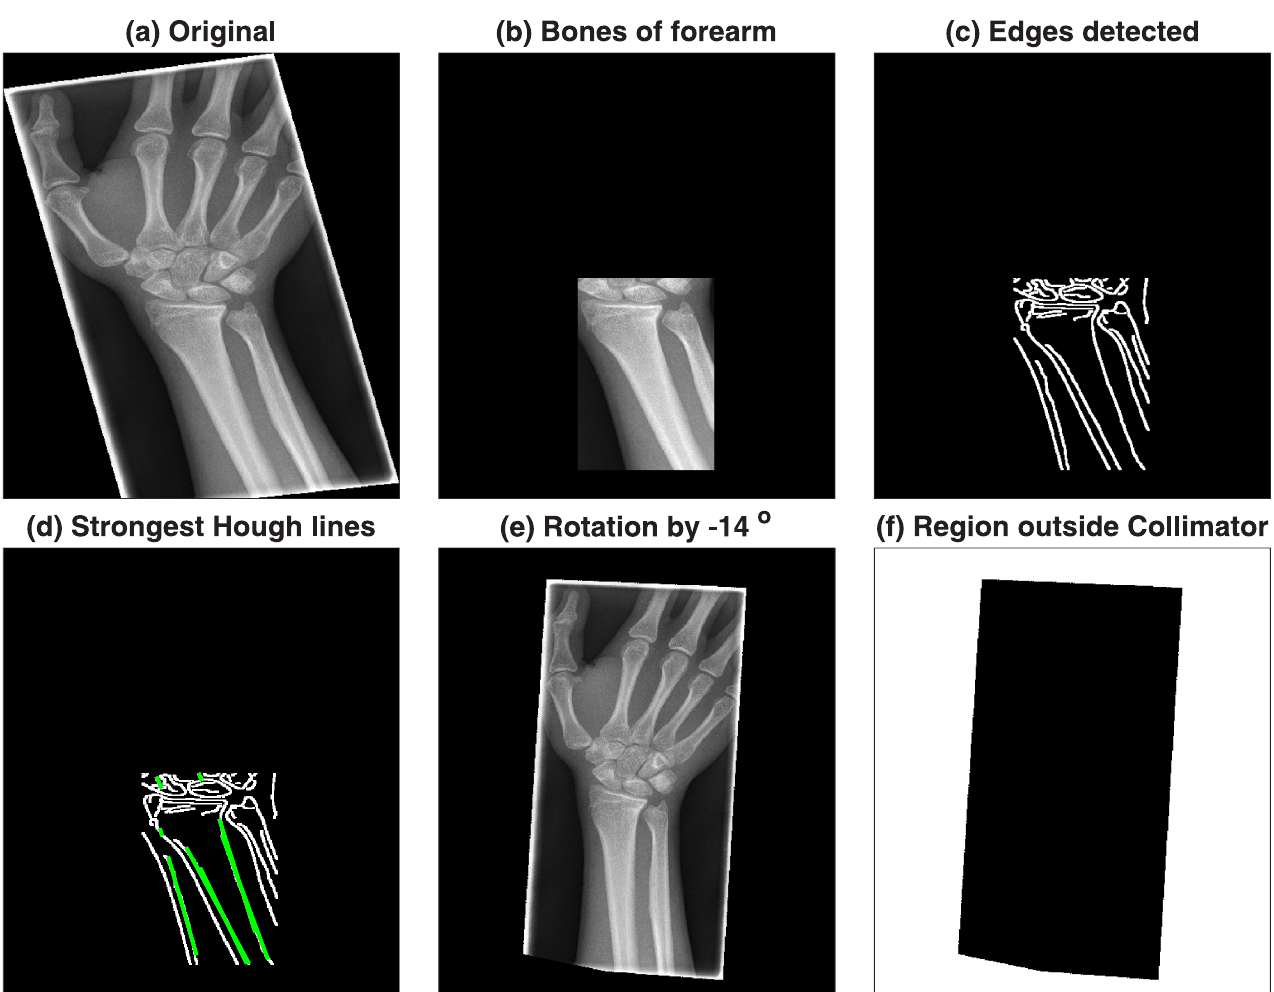
Fig 3. Graphical illustration of the steps for image analysis. Radiographs are first pre-processed by manually selecting three landmarks and then automatically rotating so that the bones of the forearm are vertical and the lines produced by the collimator are removed. Then, measurements are extracted from four regions: the bone of the middle finger, the edges of the forearm, a textured region of the radius and two intensity profile lines over the